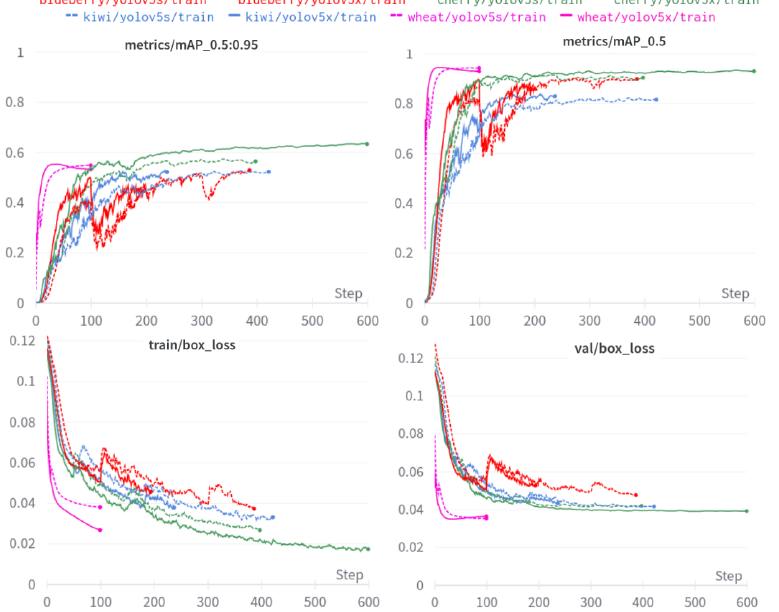
Figure 13. mAP performance metrics and train/validation bounding box loss plots for 4 newly added fruits/crops. Due to early-stopping mechanism, each experiment has a varying step length but it should have the same length for its metric and